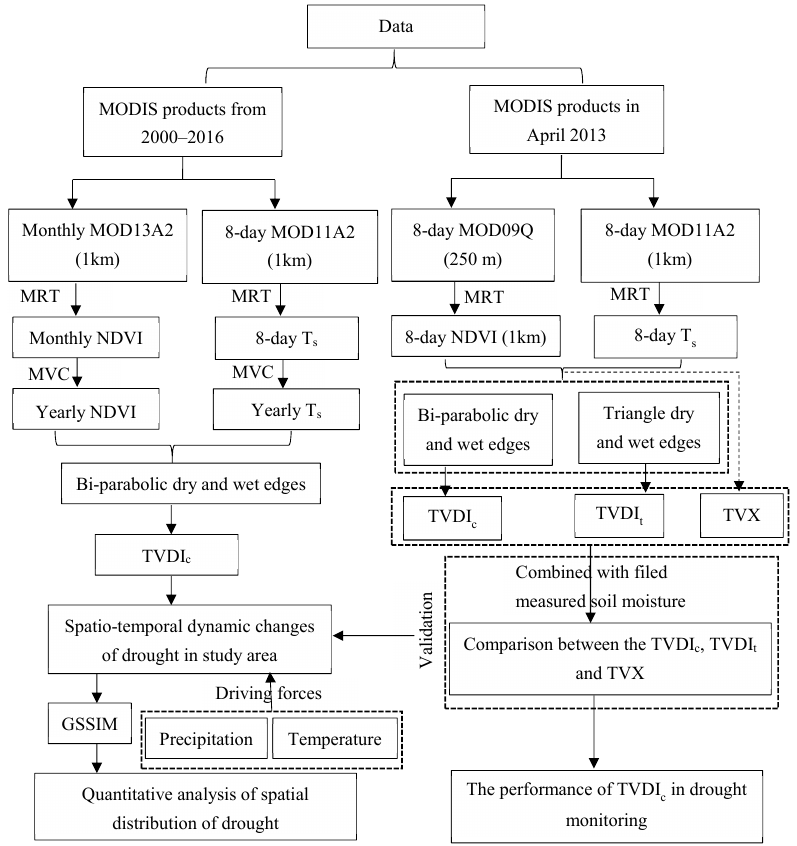
Figure 2. The flow chart of constructing bi-parabolic NDVI-T s space.